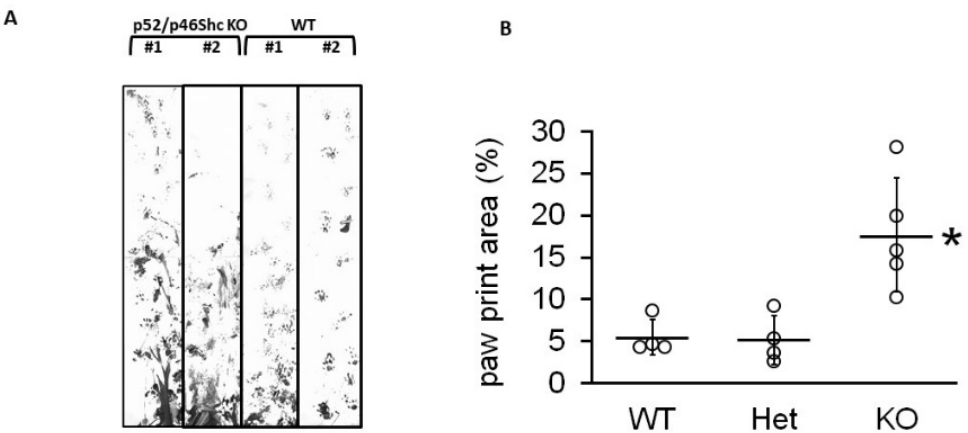
Figure 2. Gait analysis ( A ) Representative examples of gait profile were recorded for p52Shc/p46Shc-KO, two left lanes, and WT, two right lanes. In WT, a consistent step and stride pattern of paw prints was established by the end of the trace, whereas, in knockout animals, lower abdomen and/or hind paw drag created smeared traces between shorter, more irregular front paw prints. ( B ) Summary analysis of total paw print area. Het, rats heterozygous for both p52Shc/p46Shc-KO. Individual data points are shown, with horizontal lines designating mean ± standard deviation; * p = 0 .007.